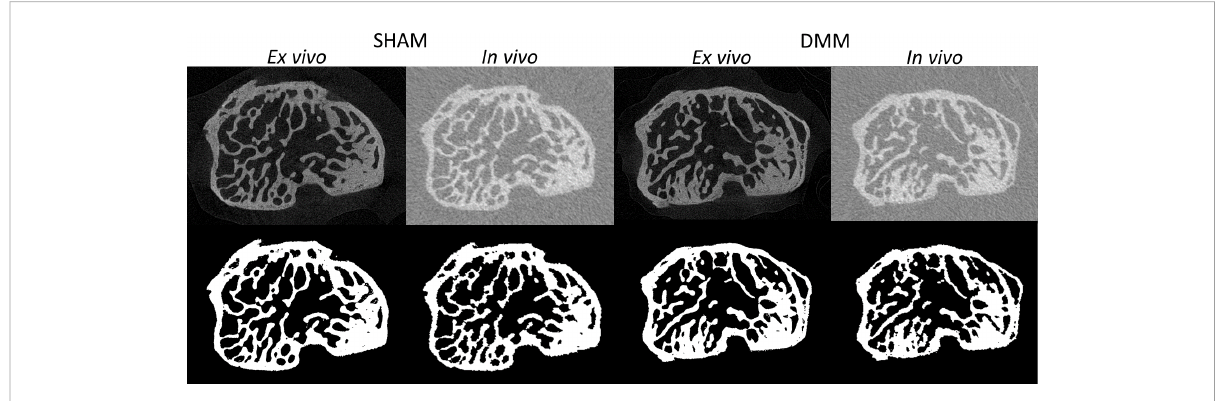
FIGURE 2 Examples of microCT cross-sections acquired in vivo and ex vivo (top), for a mouse in the SHAM group (left) and a mouse in the DMM group (right). Binary images after image segmentation are reported below each